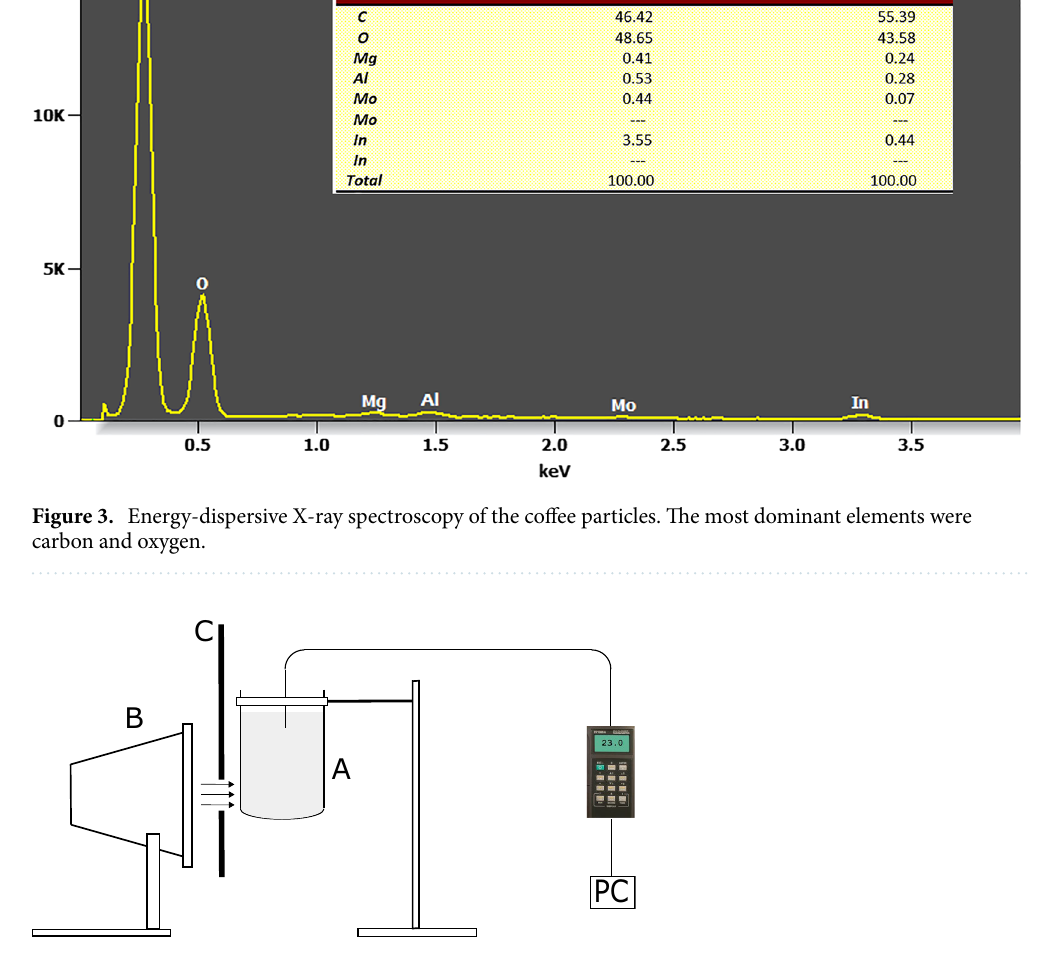
Figure 4. The schematic of indoor experiments (not to scale). A beaker with a studied liquid is subjected to halogen light (the figure was created using Inkscape version